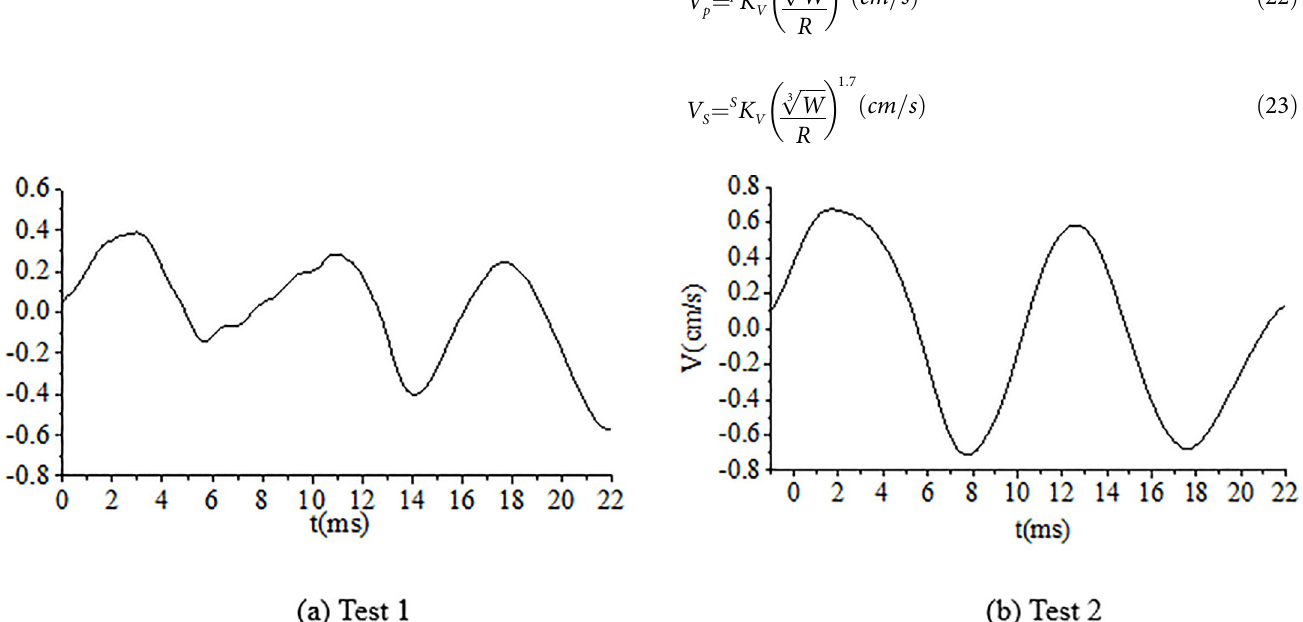
Fig 14. Vibration velocity curves of blasting signals for cut holes for a delay time of 2